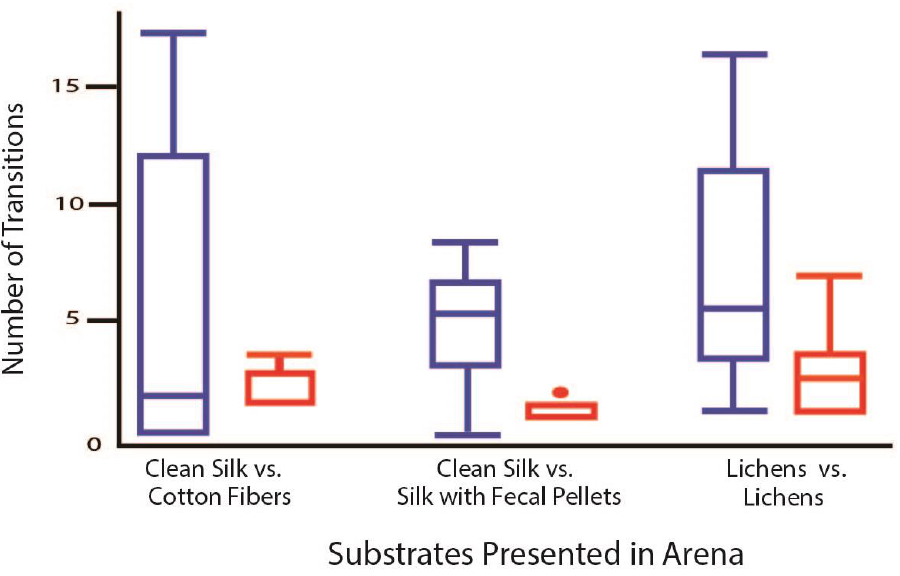
Figure 9. Transitions of E. myersi individuals between the presented four zones (see Figure 2) Blue represents transitions, where a bug walks out of empty zones; red represents transitions when a bug walks out of a zone with any of the substrates presented. See Supplementary Figure S3 for a summary of each trial.